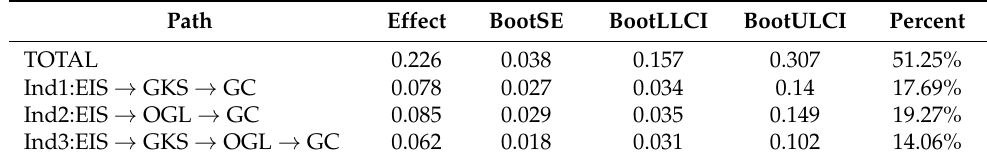
Table 5. Analysis for chain mediation